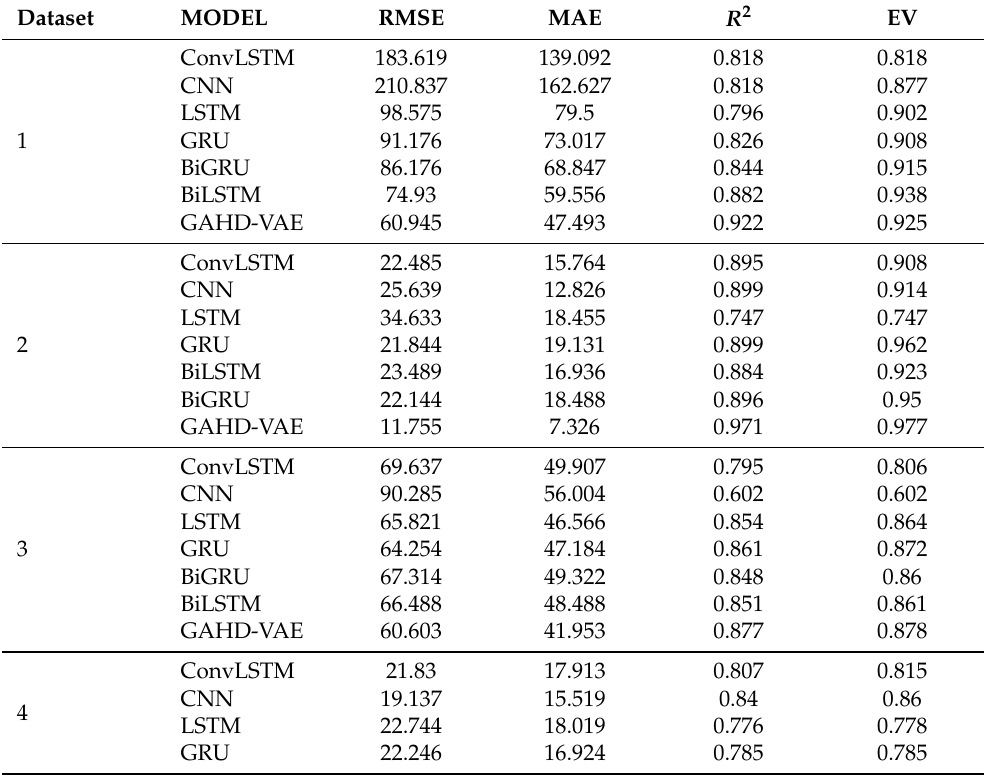
Table 8. Performance evaluation of the seven models for daily forecasting of pedestrian and bicycle traffic